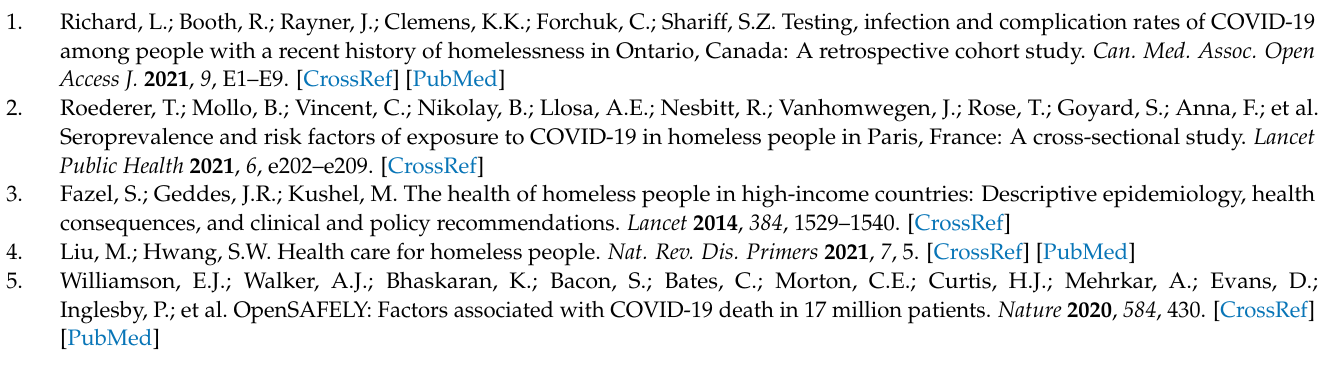
relevant for cross-sectional studies; Table S2: Full variable definitions; Table S3: Ku-gaa-gii pimitizi-win participant characteristics at baseline, overall and by vaccination dose number. Table S4: COVENANT participant characteristics at baseline, overall and by vaccination dose